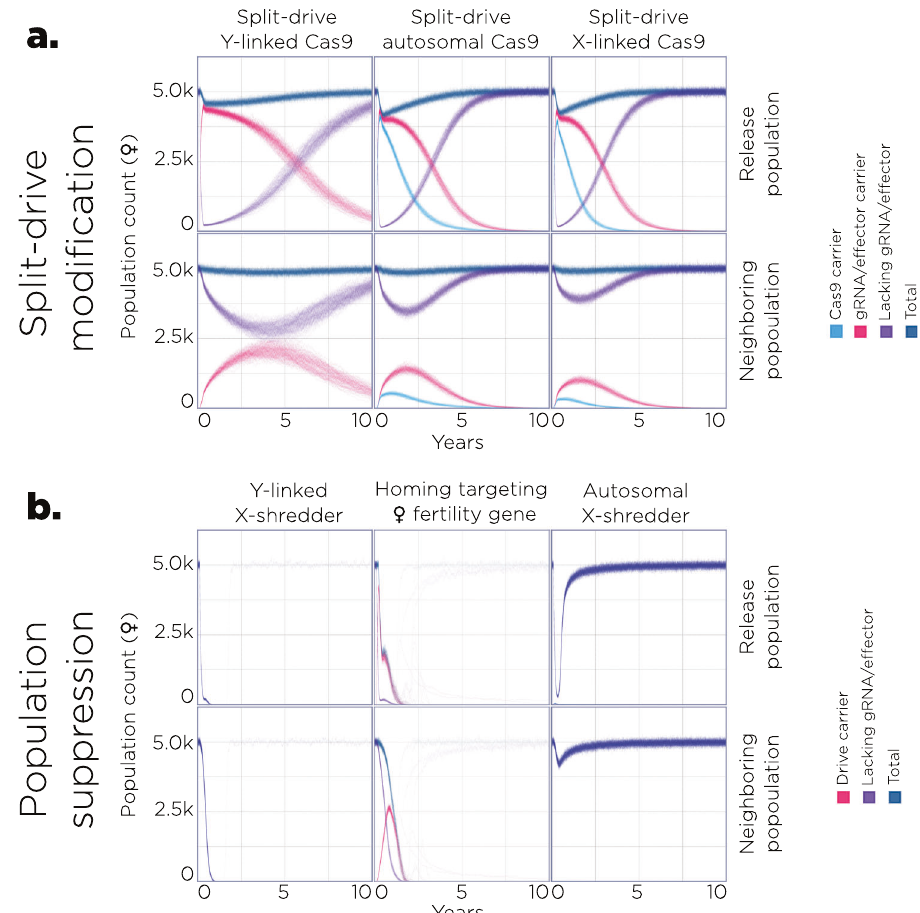
Fig. 5 Population dynamics of SGyA-based gene drive systems. a Model predictions for releases of An. gambiae mosquitoes homozygous or hemizygous for three different split drive systems intended for population modi fi cation. The SGyA-based system in which the Cas9 allele is Y-linked (left) is compared with an autosomal split drive system (middle) and a system in which the Cas9 allele is X-linked (right). In all cases, the gRNA/effector allele is autosomal. Life-history and gene drive parameters are provided in Supplementary Data File 4. 12 weekly releases were simulated in a population with an equilibrium size of 10,000 adults and a 1% per mosquito per generation migration rate with a neighboring population of the same equilibrium size. Model predictions were computed using 100 stochastic realizations of the MGDrivE framework 35 . Total adult female population size (dark blue), adult females carrying at least one copy of the gRNA/effector allele (red), adult females without the gRNA/effector allele (purple), and adult females carrying at least one copy of the Cas9 allele (light blue) were plotted for each system. Notably, for the Y-linked split drive system, the gRNA/effector allele persists longer in the population than for the autosomal or X-linked split drive systems. The Y-linked system also spreads to a higher frequency in the neighboring population. b Model predictions for equivalent releases of three population suppression systems: an SGyA-based Y-linked X-shredder (left), an autosomal homing-based drive targeting a gene required for female fertility (middle), and an autosomal X-shredder (right). Simulations assumed high rates of DNA cleavage and low rates of resistant allele generation, as required for effective population suppression 40 (Supplementary Data File 4). Total adult female population size (dark blue), adult females carrying at least one copy of the intact drive allele (red), and adult females without the intact drive allele (purple) were plotted for each system. Both the Y-linked X-shredder and autosomal homing-based drive targeting a female fertility gene achieved population elimination in >97% of simulations. The autosomal X-shredder leads to transient population suppression at the release site and limited spread to the neighboring